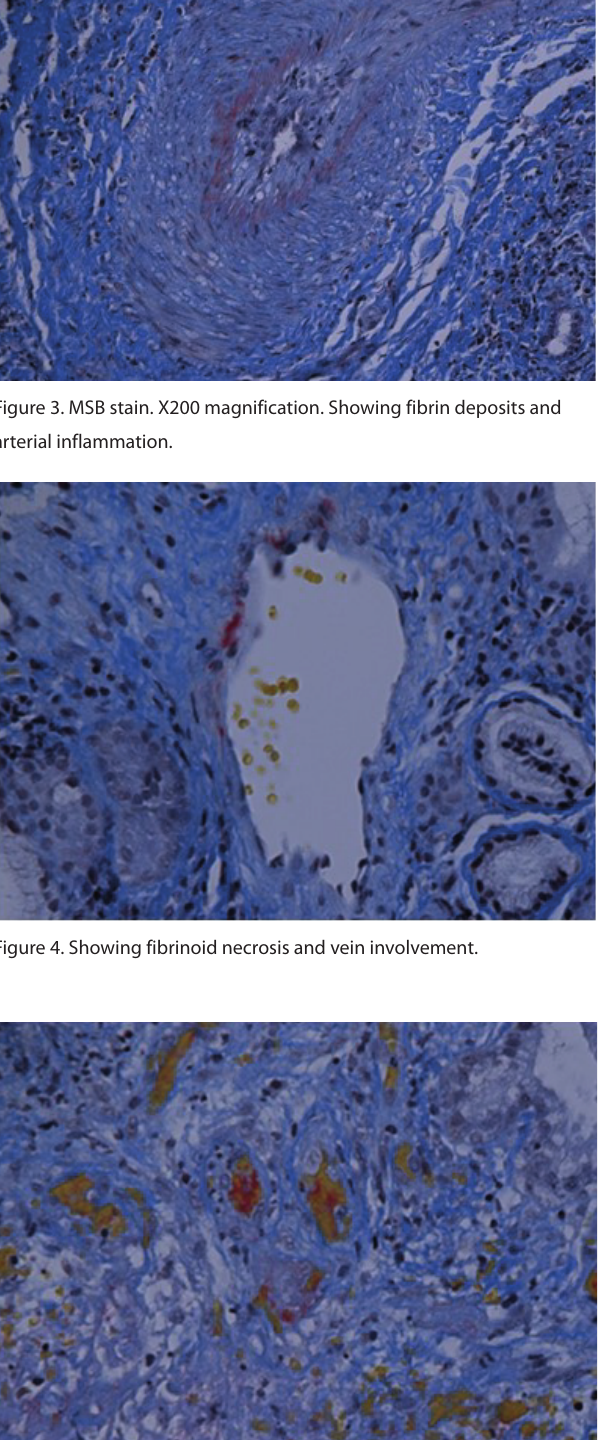
Figure 5. Showing fibirinoid necrosis with small vessel